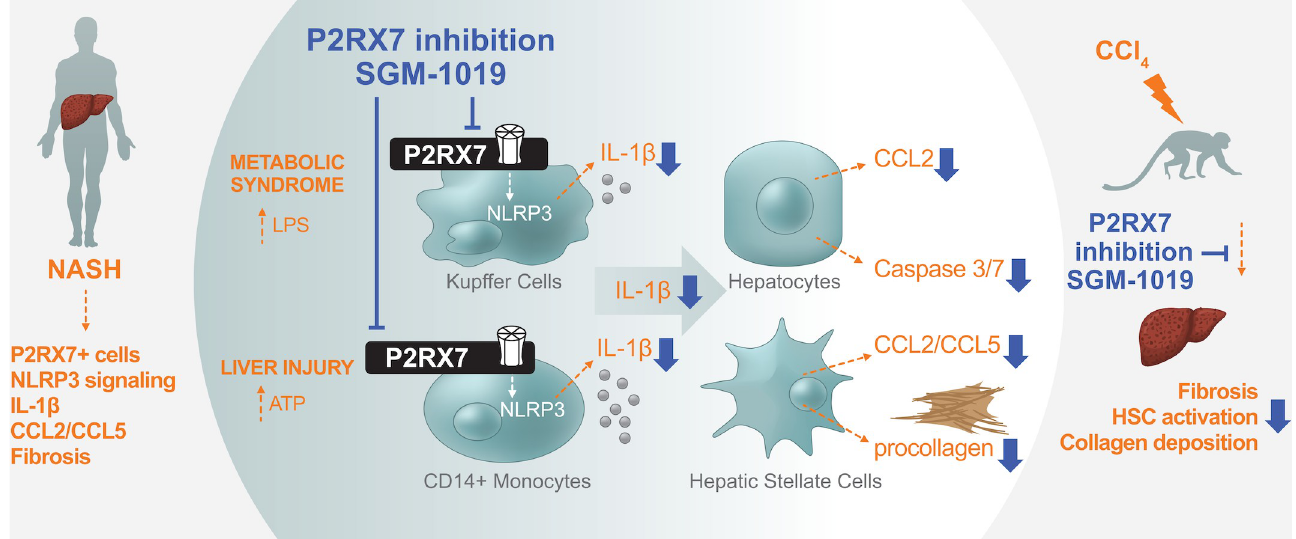
Fig 9. Schematic summary of P2RX7 in NASH-affected livers and effects of P2RX7 pharmacological inhibition in vitro and in vivo . NASH-affected livers show greater number of cells expressing P2RX7, NLRP3 inflammasome activation, IL-1 β , CCL2/CCL5 and fibrosis. P2RX7 is expressed by infiltrating MOs and resident KCs in the livers of NASH-affected individuals. Pharmacological inhibition of P2RX7 in human primary CD14 + MOs and KCs block IL-1 β release and differentially modulates their inflammatory response. Reduced P2RX7-dependent IL-1 β secretion from MOs and KCs results in decreased hepatocyte damage, chemokine secretion, and HSCs fibrosis. P2RX7 pharmacological inhibition in a more clinically translatable animal model results in significant protection from inflammation and fibrosis.